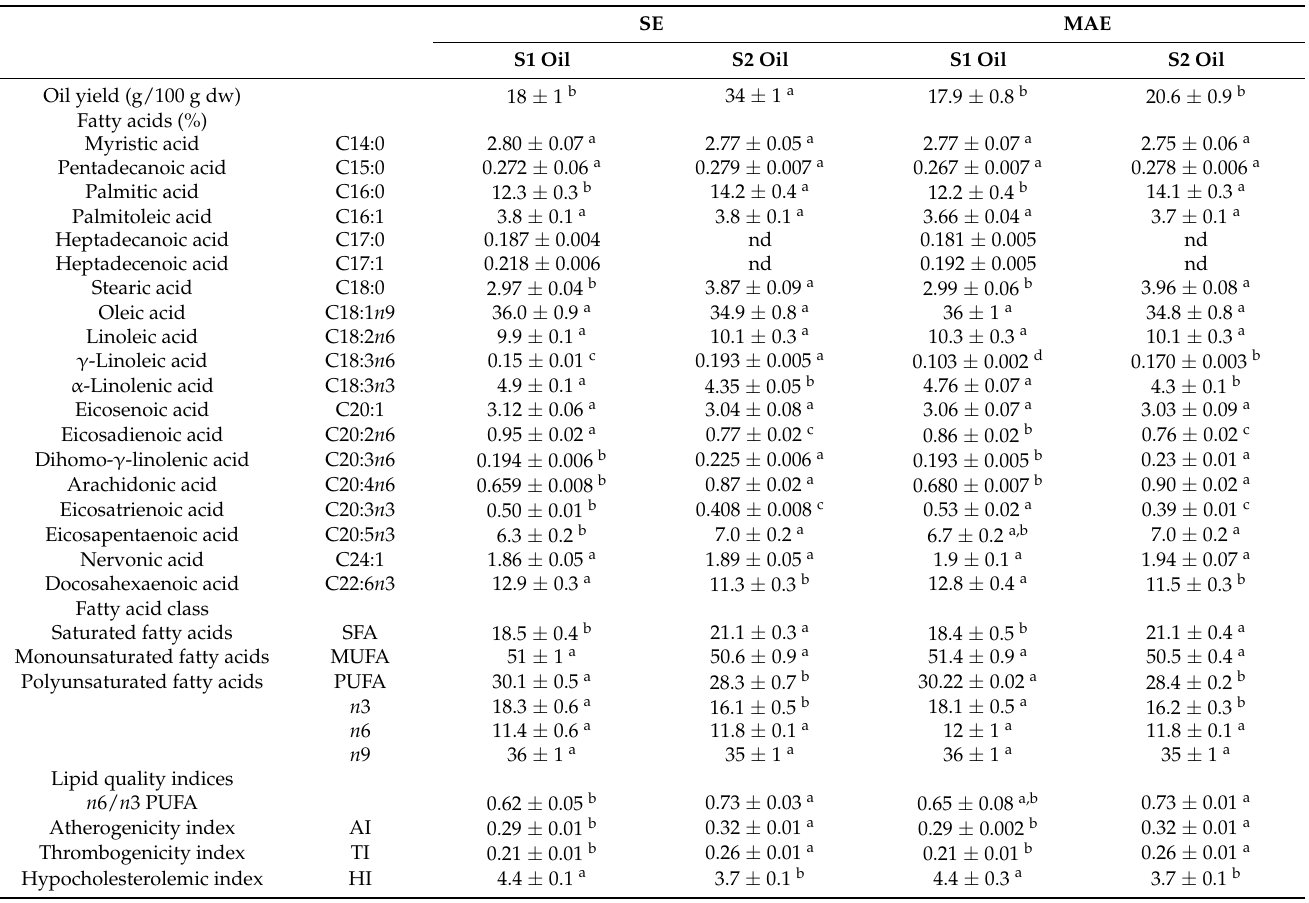
Table 4. Yield and fatty acid profile of the oils extracted from fish by-products using Soxhlet extraction (SE) and optimized microwave-assisted extraction